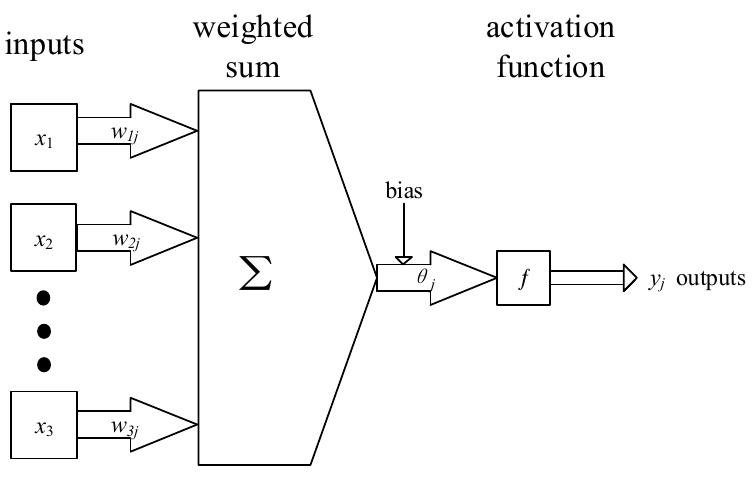
Figure 1. Artificial